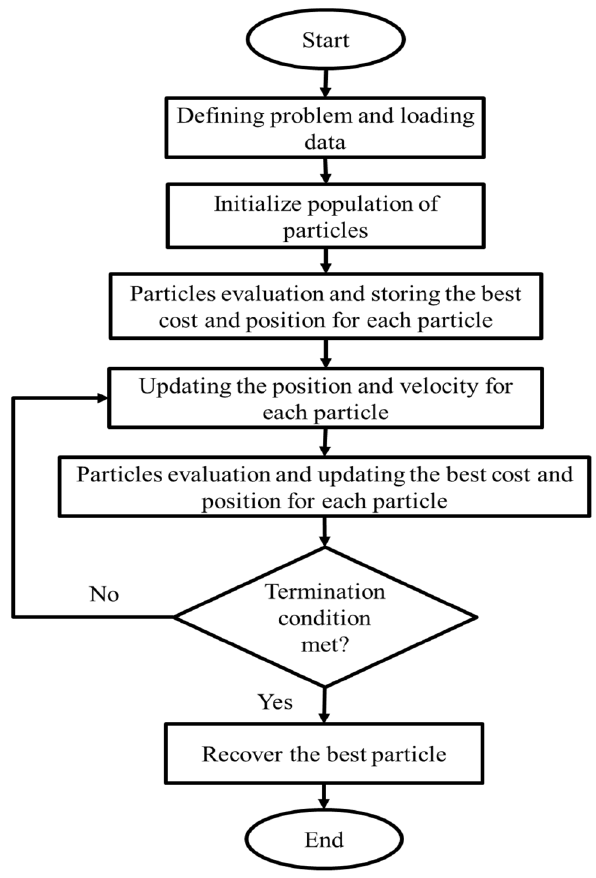
Fig. 20 Flowchart of